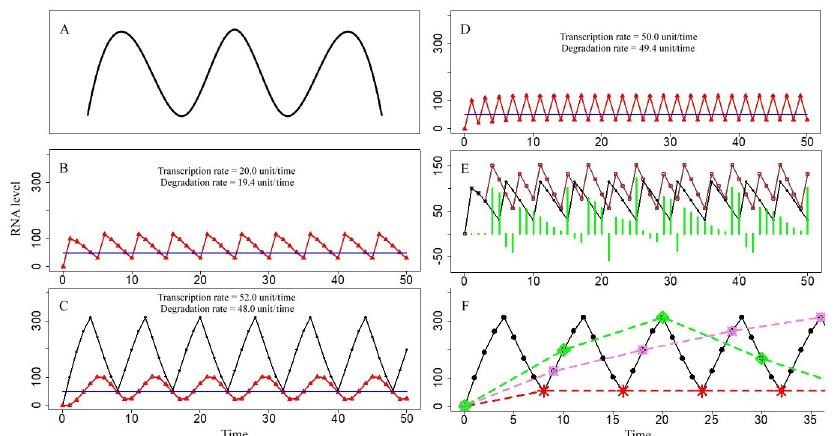
Fig 2. Cycles in RNA level fluctuations. Blue line represents the demand for RNA activity (DRA), which is set to 50. Black curve represents the total RNA amount (TR) with a DRA of 50, and points on the line are values predicted by the model. Brown curve represents TR with a DRA of 80, and hollow squares on the curve are predicted values. Red curve represents total RNA activity (TRA), and triangles on the curve are predicted values. Vertical green lines are the differences between TR with a DRA of 50 and TR with a DRA of 80. The x-axis is time, and the unit of time is RNA age, which is standardized as unitless values. The y-axis is the RNA level, which is standardized as unitless values. (A) Validation data: RNA level fluctuations reported in the literature [11,21],as shown in Fig 1B. (B) RNA level fluctuations with a cycle length of 5 RNA ages. TR and TRA curves overlap (DRA is set to 50. If TRA < DRA, then RNA level at age 0 = 100; otherwise, RNA level at age 0 = 0. The survival rate decreases at older RNA ages, i.e., the type B RNA survival rate is shown in S2 Table. The RNA activity coefficient of each RNA age is 1, i.e., the type A RNA activity coefficient in S2 Table). (C) RNA level fluctuations with cycle length longer than that in Fig 2B, resulting from reduced RNA activity coefficients (DRA is set to 50. If TRA < DRA, then RNA level at age 0 = 100; otherwise, RNA level at age 0 = 0. The survival rate decreased at older RNA ages, i.e., the type B RNA survival rate is shown in S2 Table. The RNA activity coefficient has a parabolic trend, i.e., the type C RNA activity coefficient in S2 Table). (D) RNA level fluctuations with cycle length shorter than that in Fig 2B, resulting from decreased RNA survival rates. TR and TRA curves overlap (DRA is set to 50. If TRA < DRA, then RNA level at age 0 = 100; otherwise, RNA level at age 0 = 0. The survival rate had a parabolic trend, i.e., the type C RNA survival rate is shown in S2 Table. The RNA activity coefficient of each RNA age is 1, i.e., the type A RNA activity coefficient in S2 Table). (E) Differences between TR with a DRA of 50 and TR with a DRA of 80. Green vertical lines are calculated differences between TRs with a DAR of 80 and TRs with a DRA of 50 (If TRA < DRA, then RNA level at age 0 = 100; otherwise, RNA level at age 0 = 0. The survival rate decreases at older RNA ages, i.e., the type B RNA survival rate is shown in S2 Table. The RNA activity coefficient of each RNA age is 1, i.e., the type A RNA activity coefficient in S2 Table). (F) Loss of oscillatory details in the results using various sampling times. Black solid line represents a sampling interval of 1 RNA age, and the points on the line are correct values. Red dashed line represents a sampling interval of 8 RNA ages. Violet dashed line represents a sampling interval of 9 RNA ages. Green dashed line represents a sampling interval of 10 RNA ages (DRA is set to 50. If TRA < DRA, then RNA level at age 0 = 100; otherwise, RNA level at age 0 = 0. The survival rate decreases at older RNA ages, i.e., the type B RNA survival rate is shown in S2 Table. The RNA activity coefficient of each RNA age is 1, i.e., the type A RNA activity coefficient is shown in S2 Table). ages and a peak of 313 units; a sampling interval of 8 RNA ages resulted in a stable RNA level of 53 units; a sampling interval of 9 RNA ages resulted in a wavelength of 71 RNA ages; and a sampling interval of 10 RNA ages resulted in a wavelength of 39 RNA ages. Environmental variations resulted in changes in DRA. Cyclic DRAs were able to induce new cycles of RNA dynamics (Fig 3). When DRA was changed from a stable value of 50 (Fig 2B) to a cyclic fluctuation between 50 for 5 RNA ages and 150 for 5 RNA ages, the cycle length of TR fluctuation changed from 5 RNA ages to 30 RNA ages (Fig 3B). The cycle lengths of TR and/or TRA were sometimes identical to those of cyclic DRA (Fig 3C). Aperiodic DRA elimi- nated the oscillations of RNA dynamics (Fig 3D). Simulated outcomes in which TR fluctuation was influenced by environmental variations matched the single-cell gene expression patterns reported in other studies, as shown in Figs 3A [12] and 1C [37] and S1C [21]. Sub-cycles of RNA dynamics were expected to occur during sufficiently long stable periods of cyclic DRA.